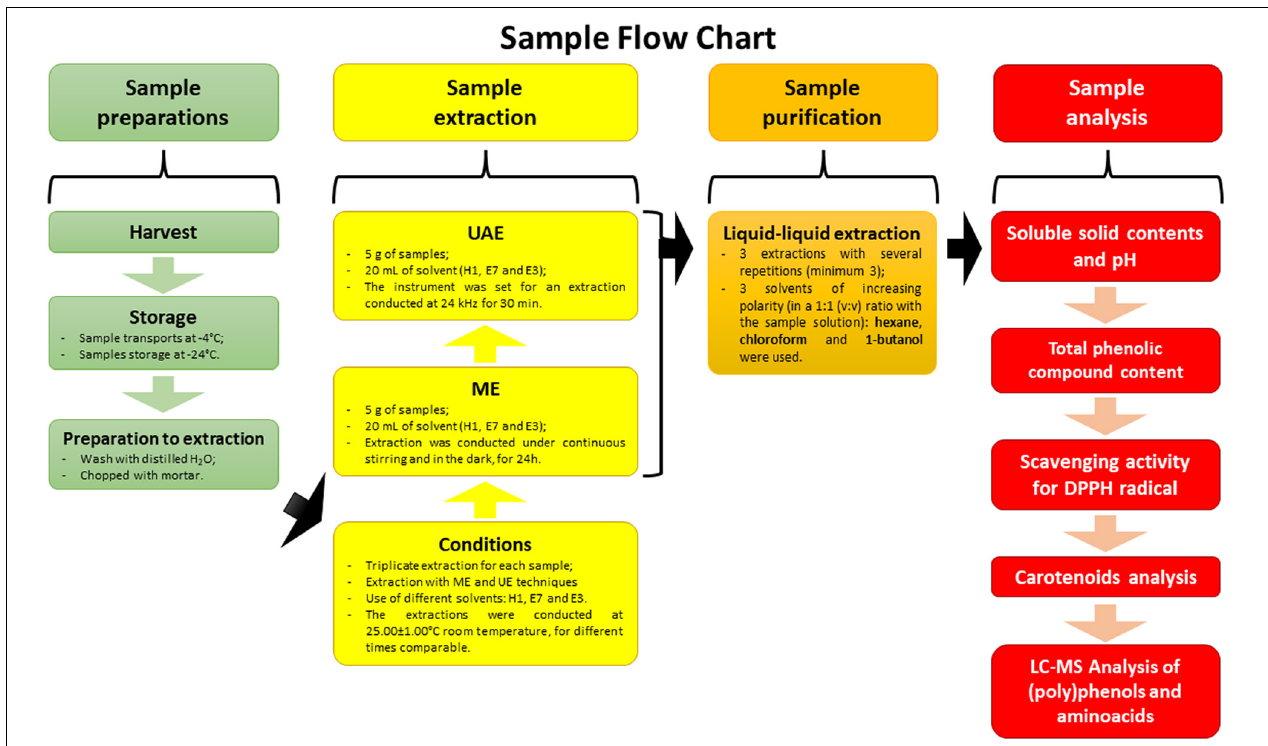
FIGURE 1 | Graphical representation with sample flow chart: V, green fruit; G, yellow fruit; A, orange fruit; R, red fruit; H1, extraction with 100% H 2 O; E7, extraction with 70% EtOH in hydroalcoholic solution; E3, extraction with 30% EtOH in hydroalcoholic solution; ME, maceration extraction; UAE, ultrasound-assisted extraction; DPPH, 2,2-diphenyl-1-picrylhydrazyl